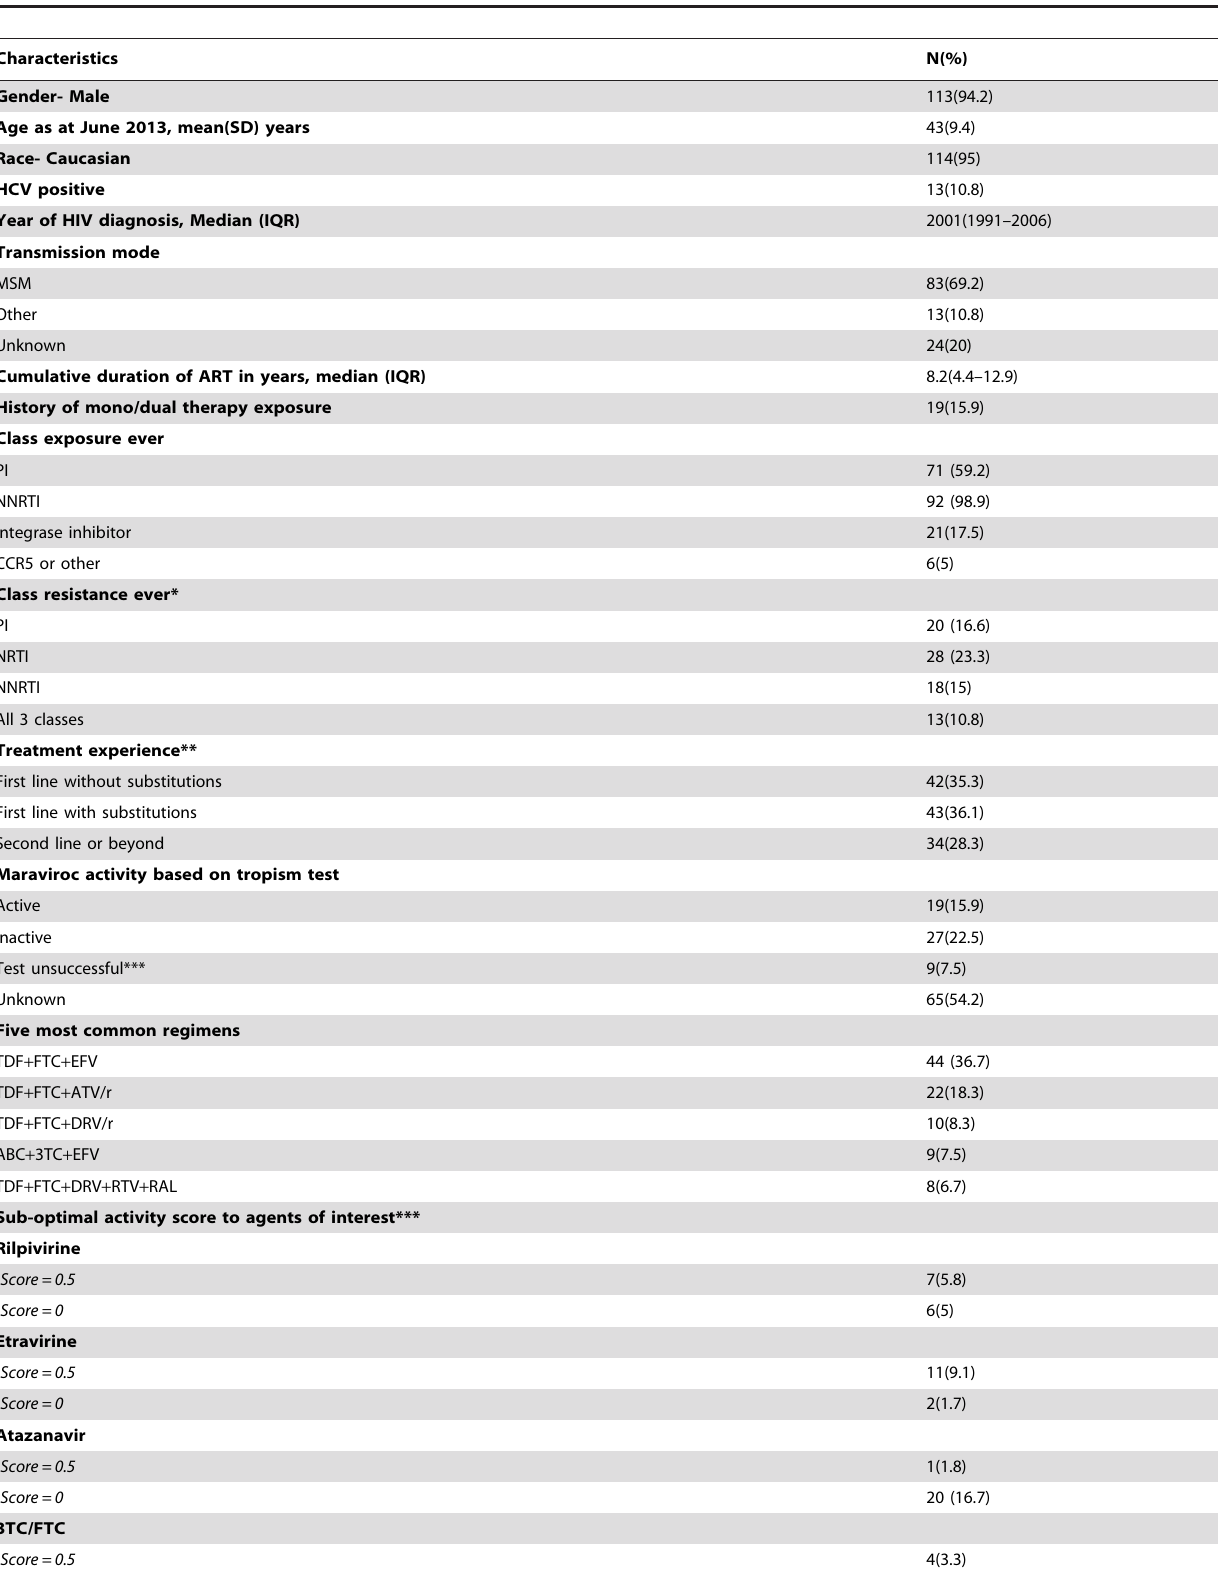
Table 1. Patient characteristics in the Hospital Database (n=120).